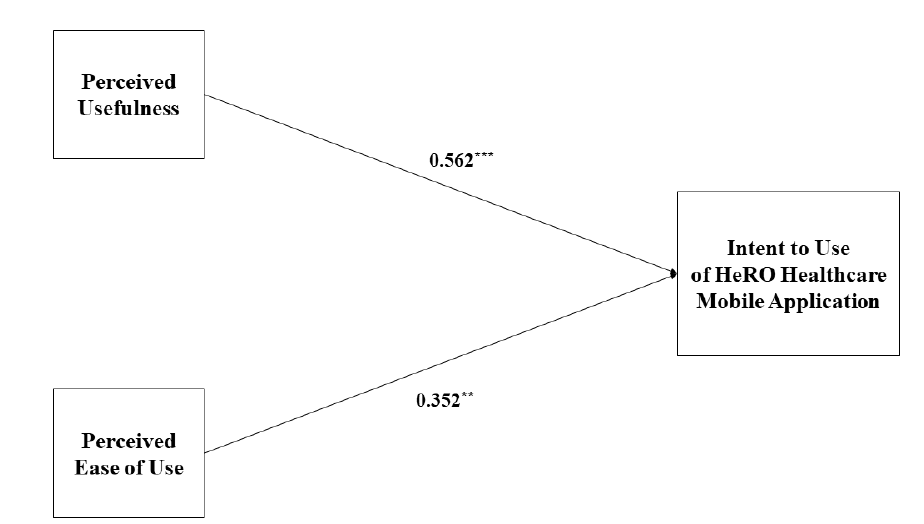
Figure 3. Path analysis of HeRO healthcare mobile application likelihood of use based on multiple regression model. * p < 0.05, ** p < 0.01, *** p < 0.001.